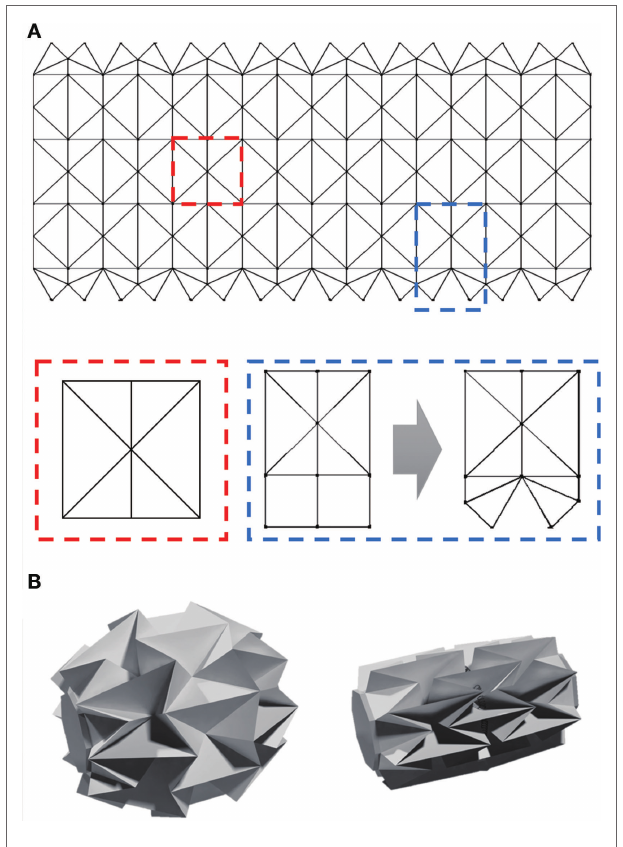
FigUre 3 | Origami pattern and assembled shape of the transformable wheel . (a) The entire pattern is composed of a repeated 3 × 8 unit pattern (known as the waterbomb pattern; red box). One end of the base pattern was modified to build a structure that connects to the shaft hub (blue box). (B) The diameter of the wheel structure can be changed by contracting both sides of the wheel.